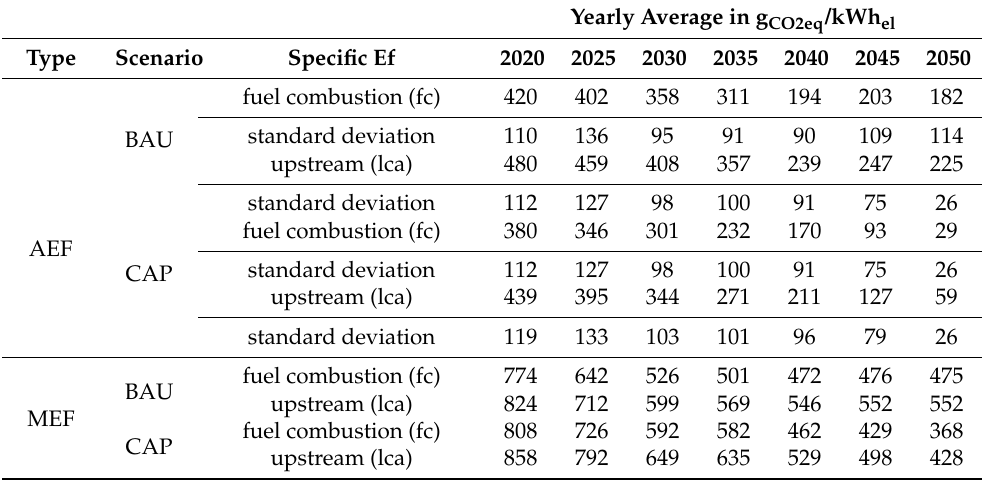
Table 2. Annual average emission factors by characteristic, scenario, fuel-specific factors, and the associated standard deviation of the hourly values. Model